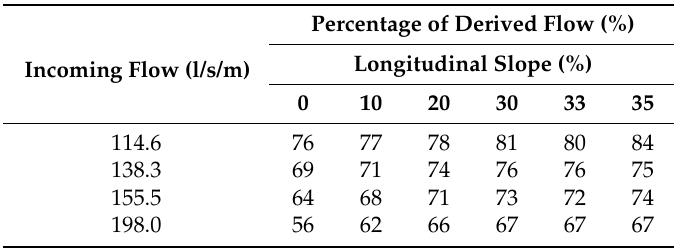
Figure 6. Percentage of derived flow for a specific inlet flow: ( a ) 114.6 l/s/m; ( b ) 138.3 l/s/m; ( c ) 155.5 l/s/m; ( d ) 198.0 l/s/m. Table 4. Percentage of derived flow.